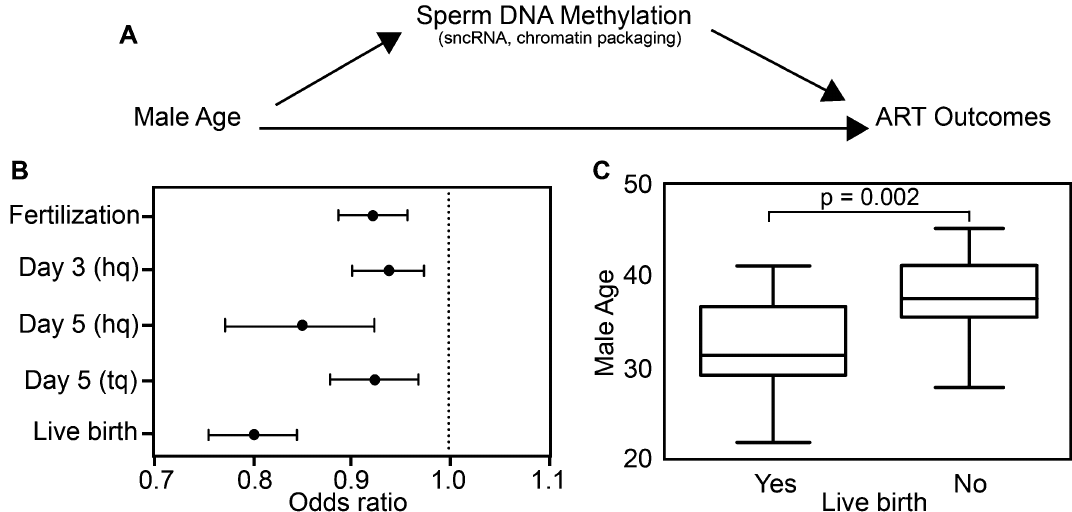
Figure 1. Male age and assisted reproductive technology (ART) outcomes. ( A ) Flow chart of our a priori hypothesis that sperm DNA methylation mediates the effect of male age on ART outcomes. Other potential epigenetic mechanisms not included in this study are listed below sperm DNA methylation including small noncoding RNA and chromatin packaging. ( B ) Odds ratios between male age and ART outcomes adjusting for male BMI, infertility, smoking and female age. ( C ) Unadjusted box plots of male age for couples with and without successful live births (t-test: − 3.48 p-value = 0.002). hq: high quality embryo; tq: transfer quality